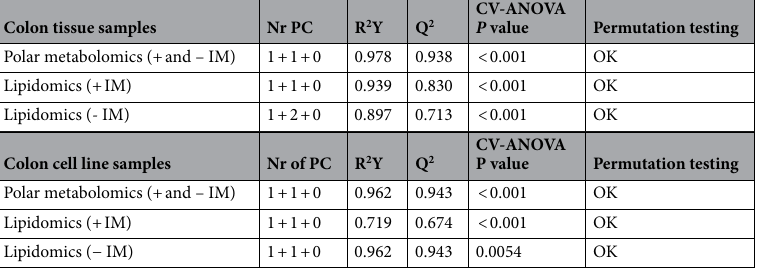
Table 1. Validation parameter values of OPLS-DA models using whole untargeted datasets (PC = Principal Components; IM = Ionization